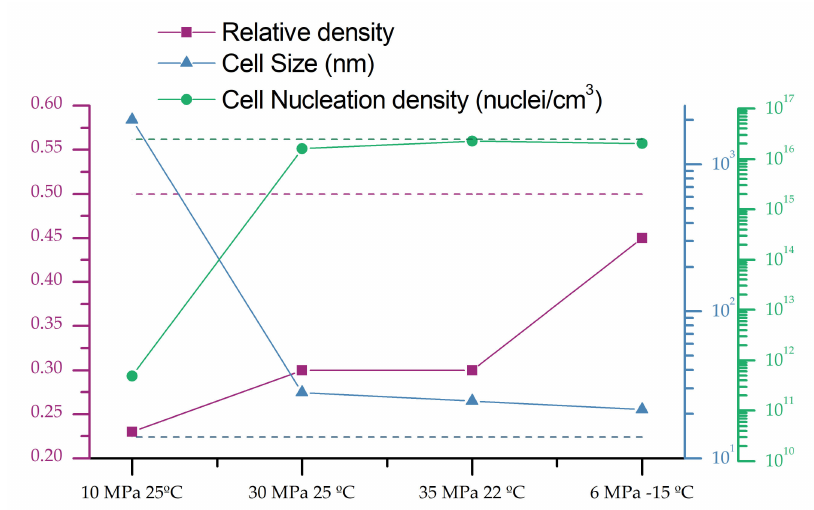
Figure 6. Relative density, cell size, and cell nucleation density of the samples produced with two cycles (10 MPa 25 ◦ C, 30 MPa 25 ◦ C, 35 MPa 22 ◦ C and 6 MPa − 15 ◦ C and foamed at 80 ◦ C for 1 min) by fixing the saturation parameters in the first cycle at 20 MPa and − 32 ◦ C and foamed at 60 ◦ C for 1 min. The dotted line indicates the values obtained in a single cycle process at 20 MPa and − 32 ◦ C and foamed at 60 ◦ C for 1